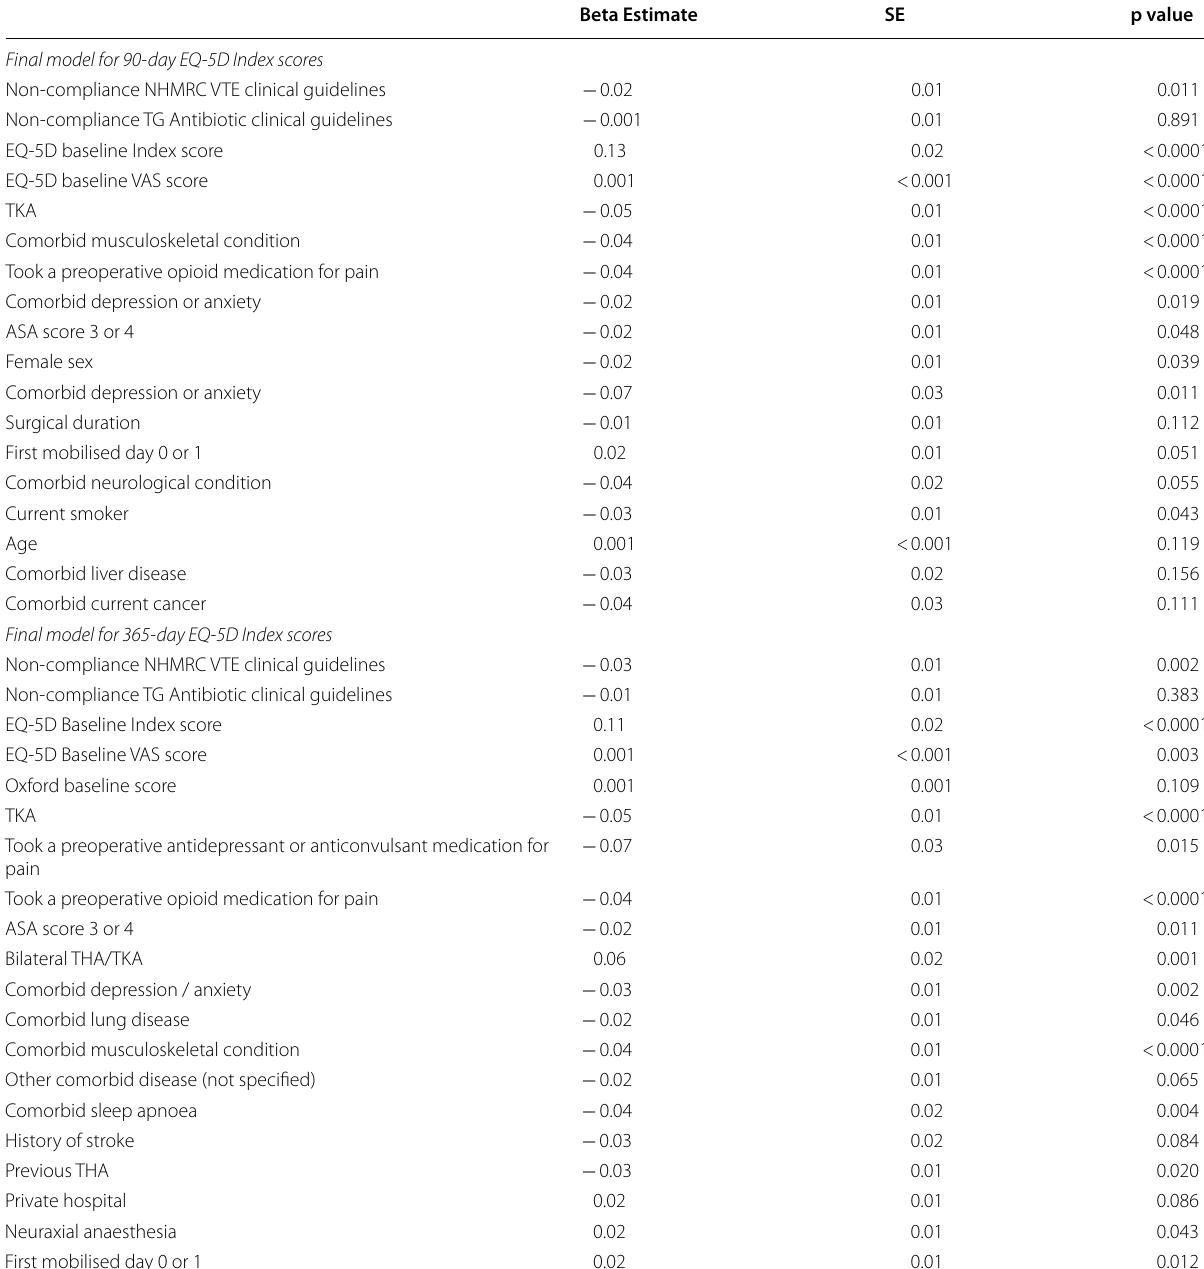
Table 7 Association between clinical guideline non‑compliance and EQ‑5D Index score at 90